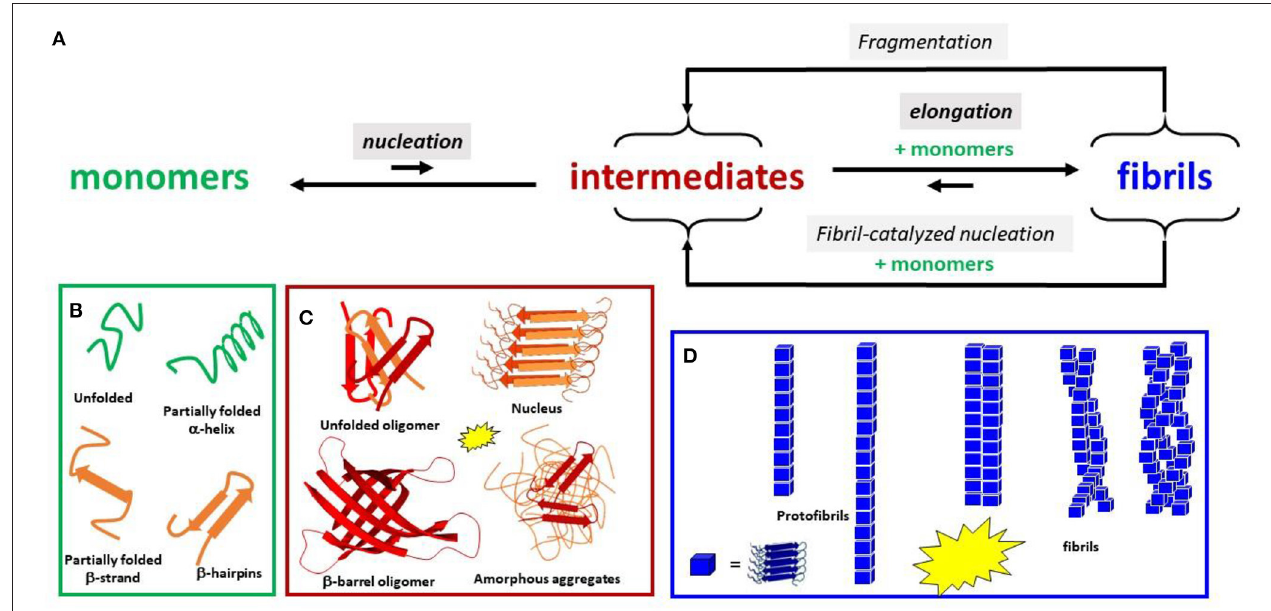
FIGURE 1 | (A) Schematic view of the aggregation A β process. Only the main steps of the process are shown. Intensities of the fluorescence dye used as a probe of β -sheet content are shown by the yellow stars for the species formed. Several species are in equilibrium between each primary step: (B) monomeric conformers, (C) oligomers, and (D) fibrillary